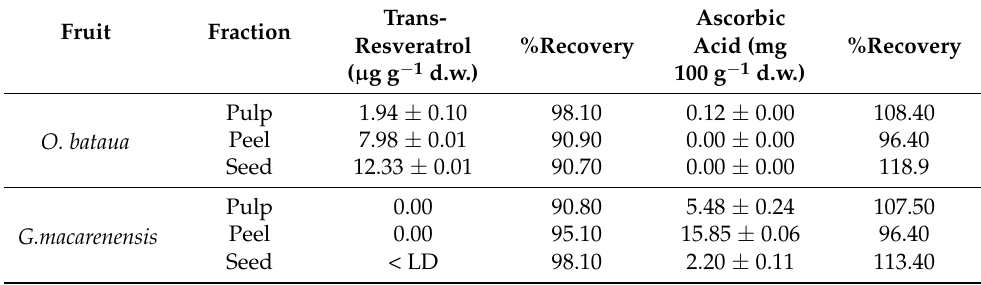
Table 5. Resveratrol and ascorbic acid content in the evaluated fruit